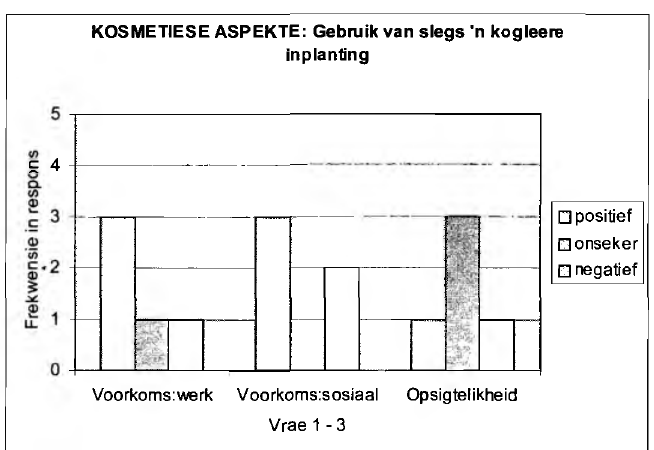
Figuur 3a: Deelnemers se ervarings aangaande die gebruik van slegs die kogleSre inplanting in terme van kosmetiese aspekte.